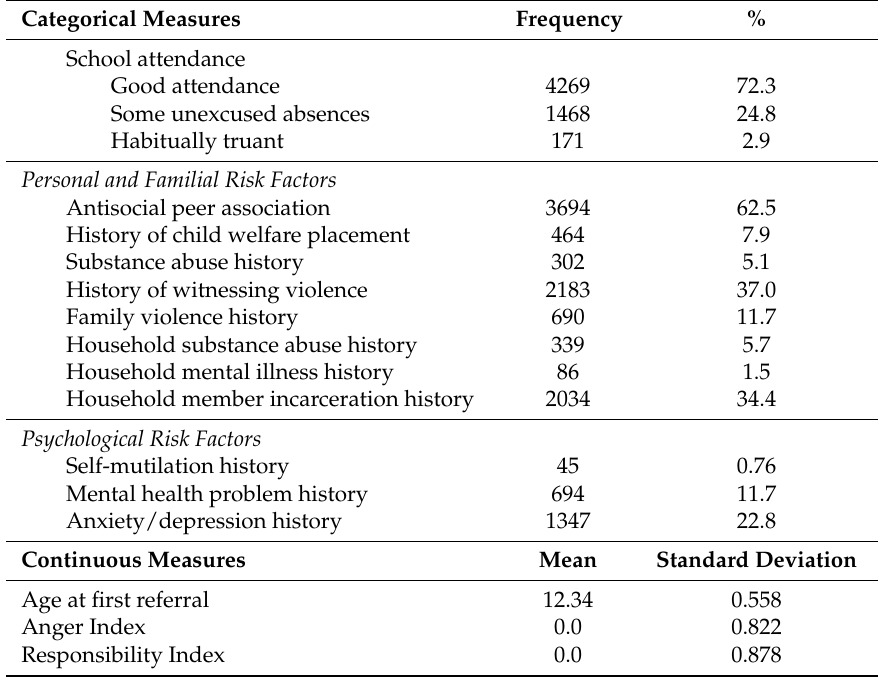
Table 2. Rare-event logistic regression results for the analysis of prospective homicide offenders ( n =